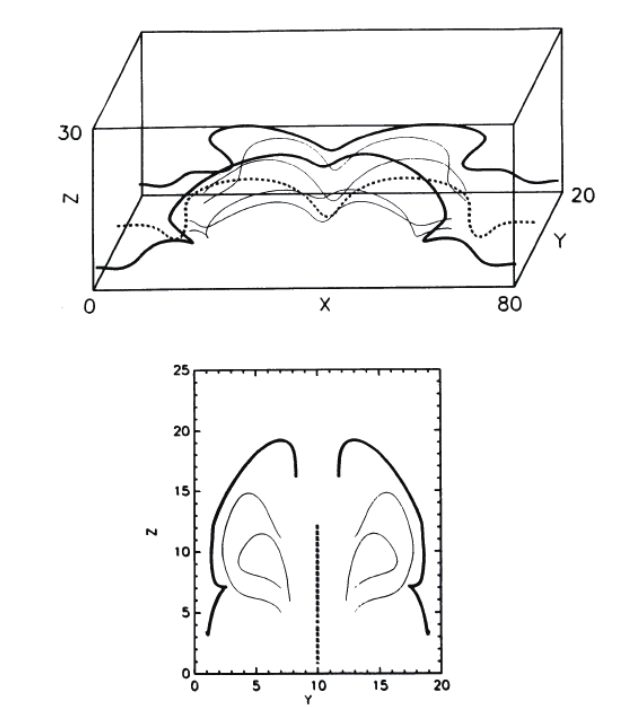
Figure 18: Magnetic field lines in the 3D MHD simulation of emerging flux. Image reproduced with permission from Matsumoto et al. (1993), copyright by